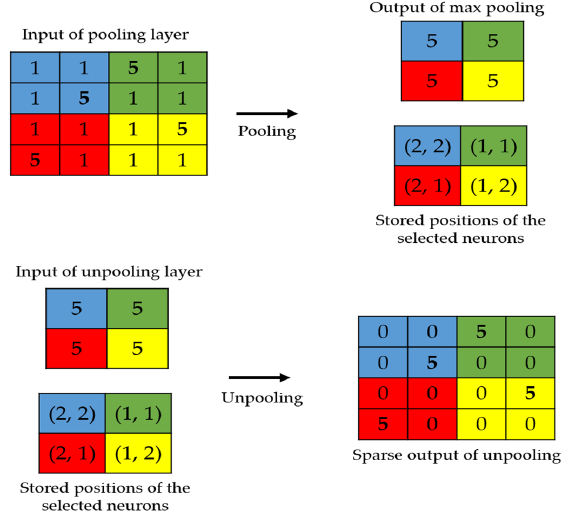
Figure 2. Illustration of the storage technique. The positions of the strongest activations are utilized in order to produce the sparse output.